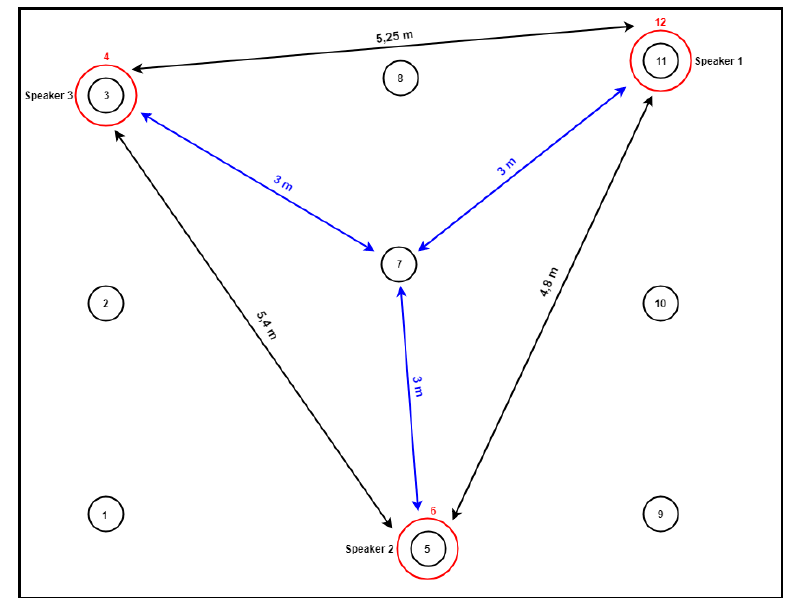
Figure 10. Topology of smart speakers in the room, where the tests took